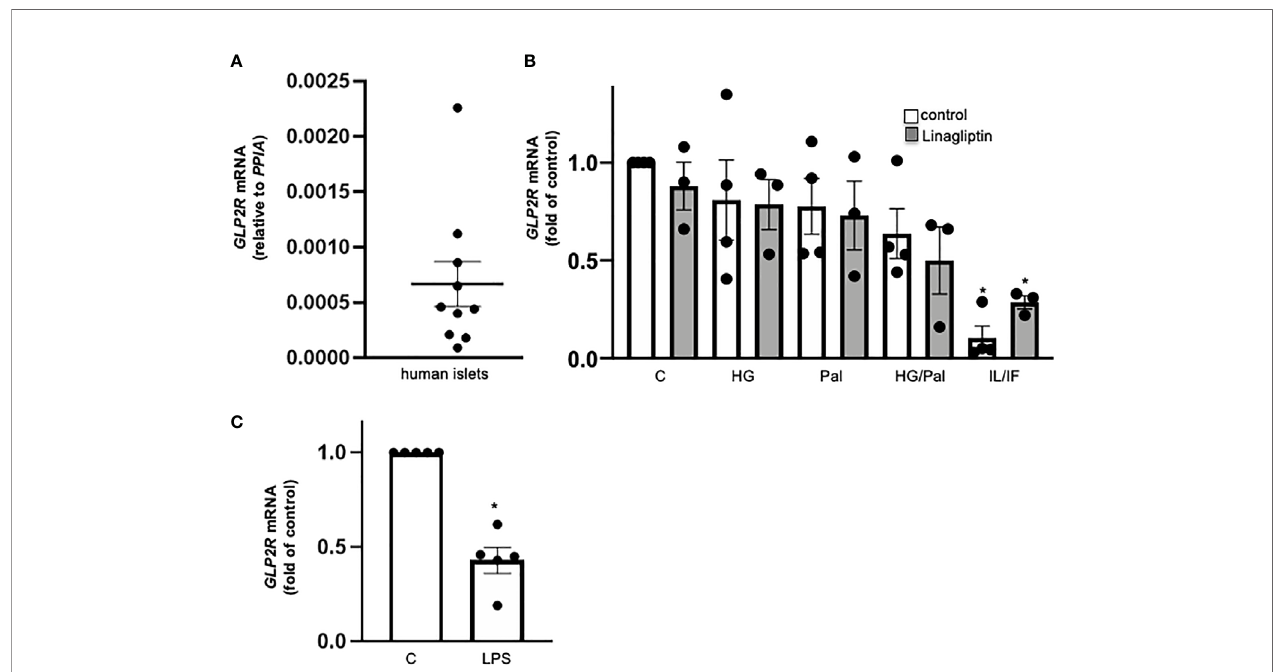
FIGURE 2 | GLP-2R expression in isolated human islets. Isolated human islets were cultured on ECM-coated dishes for 24h (A, C) or 72h (B) under control medium (A) or with 22.2 mM glucose (HG), 0.5 mM palmitate (Pal), or combined HG/Pal or 2 ng/ml IL-1 b plus 1,000 U/ml IFN- g (IL/IF), in the absence (control) or presence of 30 nM linagliptin (B) or with 20 m g/ml LPS (C) . Total mRNA was isolated and GLP2R mRNA analyzed by realtime RT-PCR. Data are shown as means ± SEM from n = 10 (A) , 4 (B) or 5 (C) different human islet isolations. *p < 0.05 diabetogenic conditions vs . control by (B) 1-way ANOVA with Dunnet ’ s post-test or (C) paired two-tailed